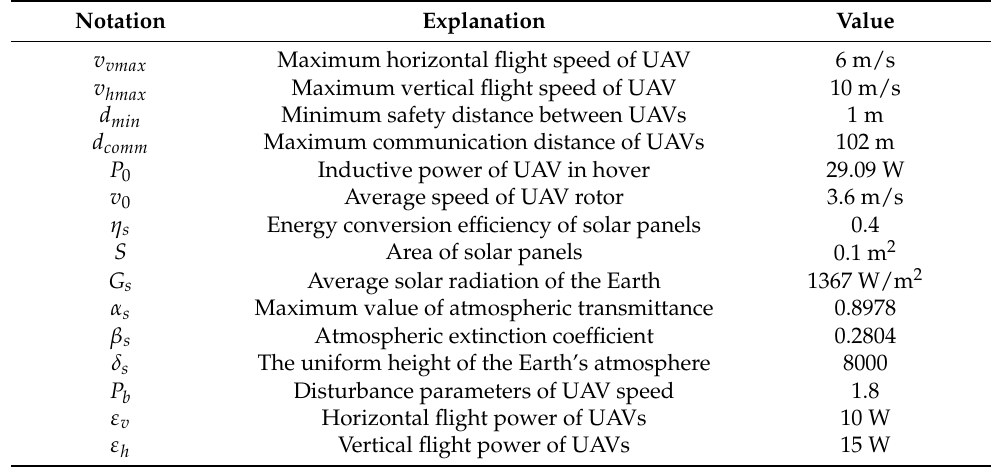
Table 3. List of important parameters in this